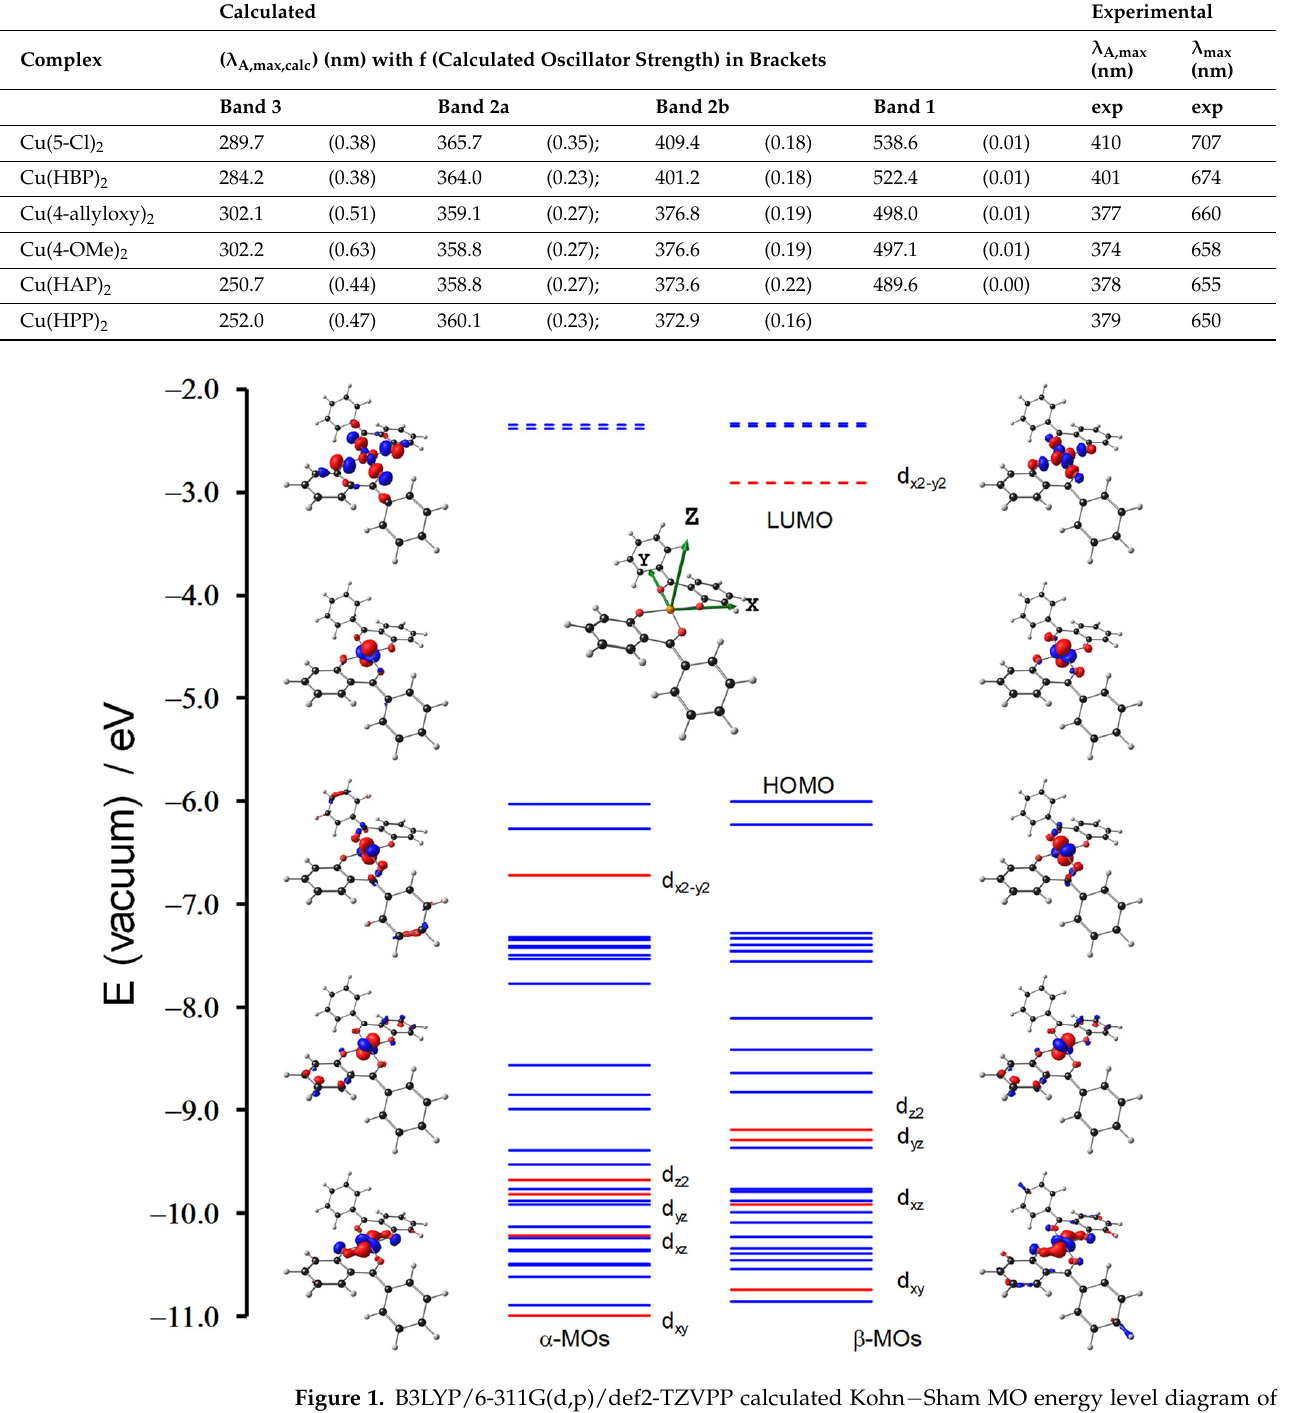
Figure 1. B3LYP/6-311G(d,p)/def2-TZVPP calculated Kohn − Sham MO energy level diagram of Cu(HBP) 2 ( 5 ) with the mainly copper-d-based MOs shown. The energy of occupied and unoccupied MO energy levels is shown with solid and dotted lines, respectively. Mainly copper-d-based and ligand-based MOs are shown in red and blue, respectively. A contour of 0.06 e/Å 3 was used for the orbital plot. Colour code of atoms (online version): Cu (orange), C (grey), O (red), H (white).